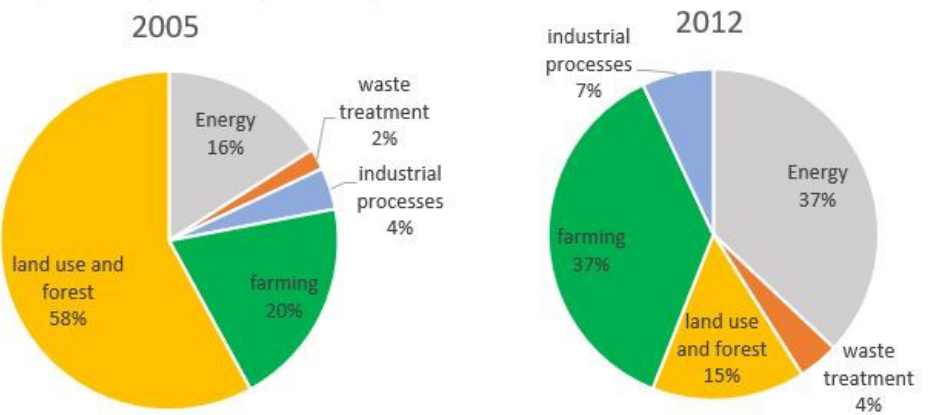
Figure 4. Comparison of the representativeness of greenhouse gas (GHG) emissions (CO 2-eq ) by sector in Brazil from 2005–2012. Data were sourced from Reference [16].